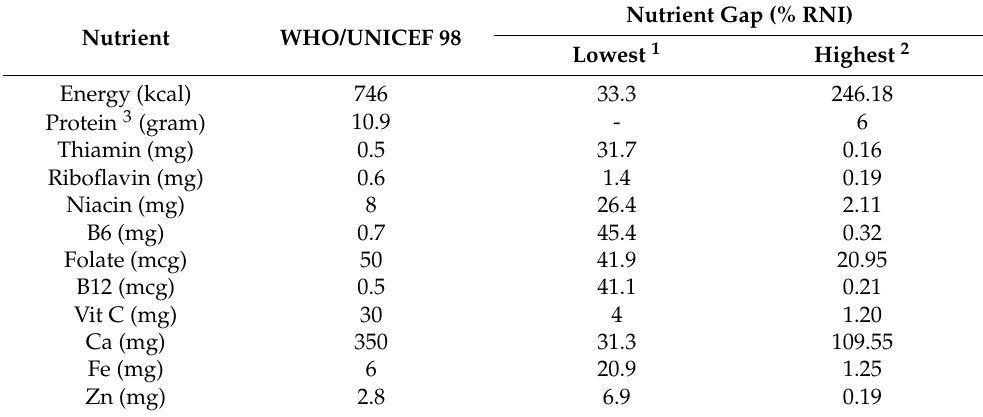
Table 4. Minimal Nutrient Target for